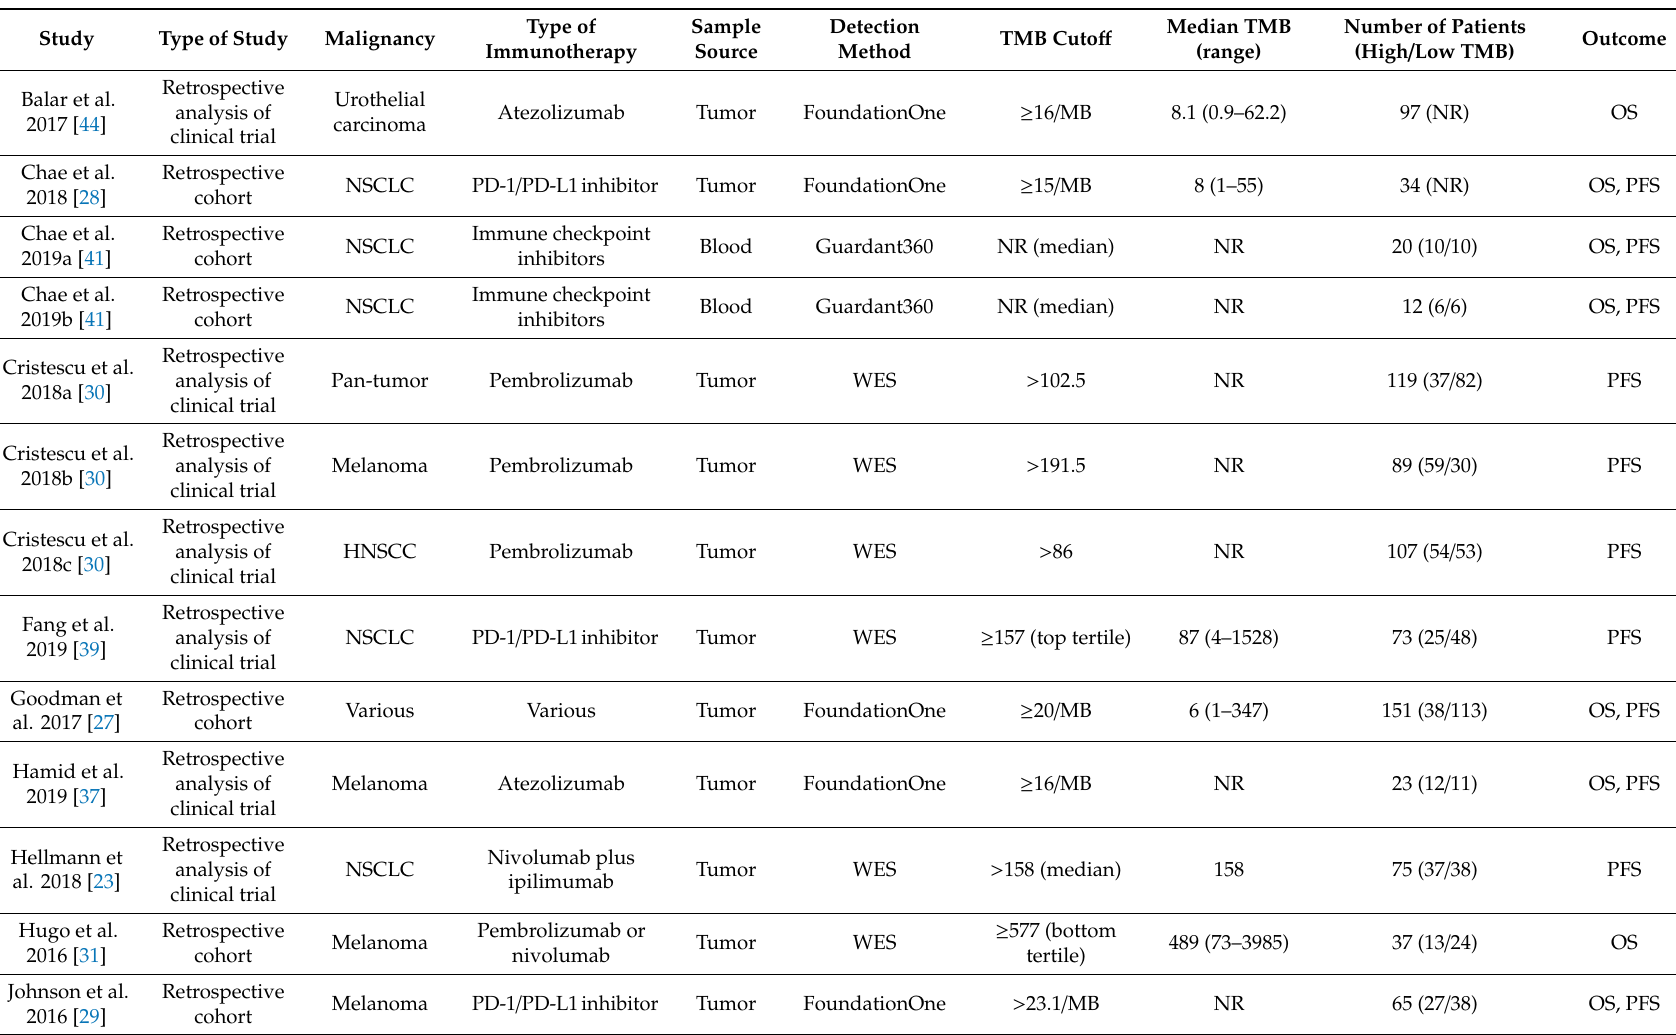
Table 1. Characteristics of studies included in the meta-analysis of the high tumor mutational burden (TMB) group versus low TMB